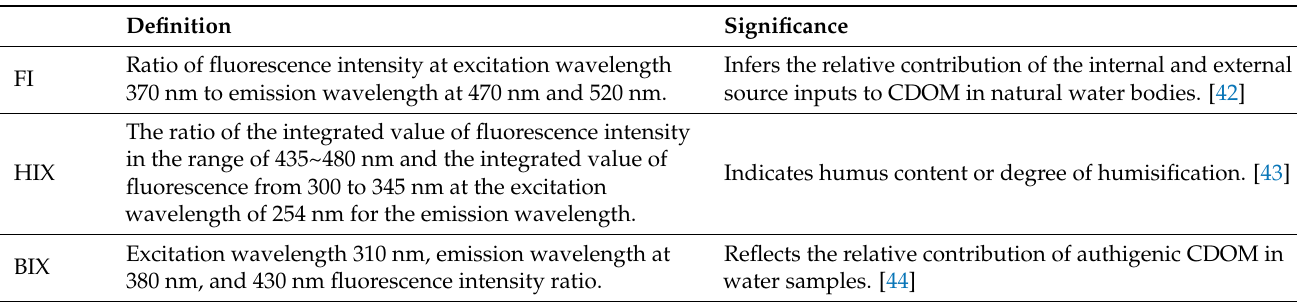
Figure 6. The percentage of the three fluorescent components of the DOM in the drip water of Daxiao Cave. Each bar represents a sample point, sorted from left to right by DX-1, DX-2, DX-3, DX-4, DX-5, and DX-C for each month, where the DX-4 and DX-5 data for October and November are missing. Table 3. Equations and significance of fluorescence parameters